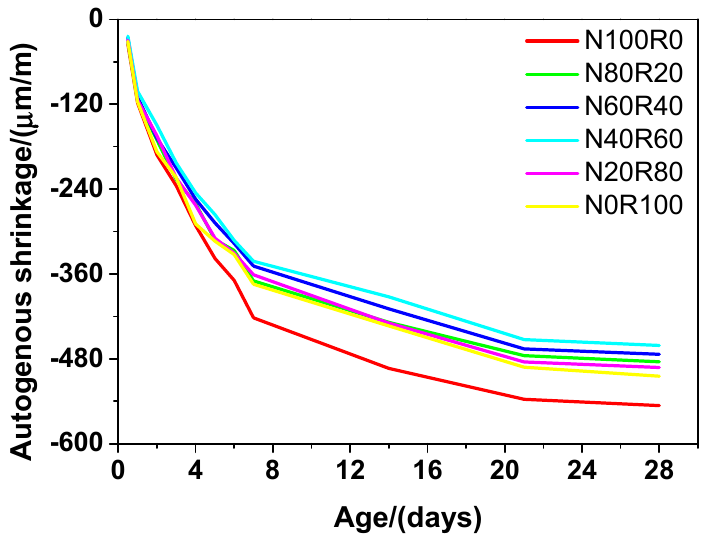
Figure 4. Autogenous shrinkage of UHPC.